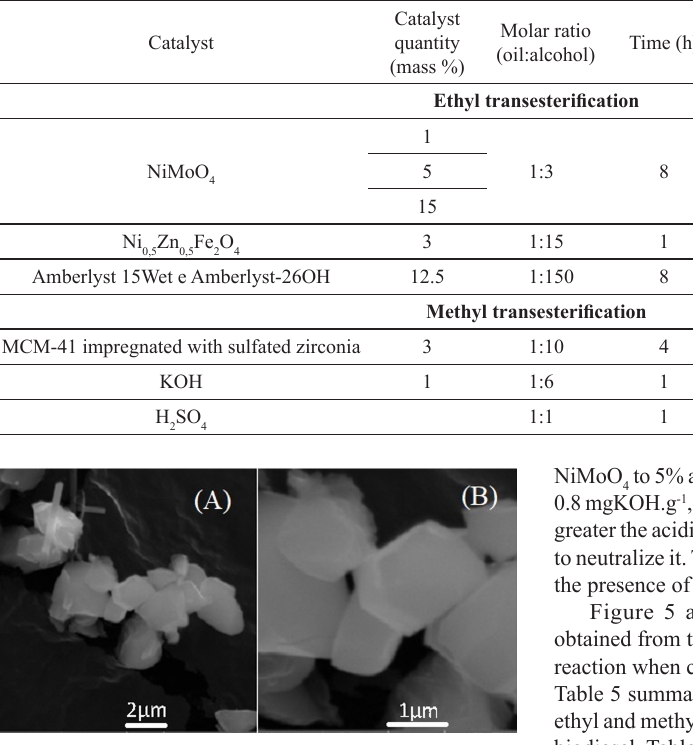
Figure 4. SEM images of the NiMoO (B) 45 Kx.